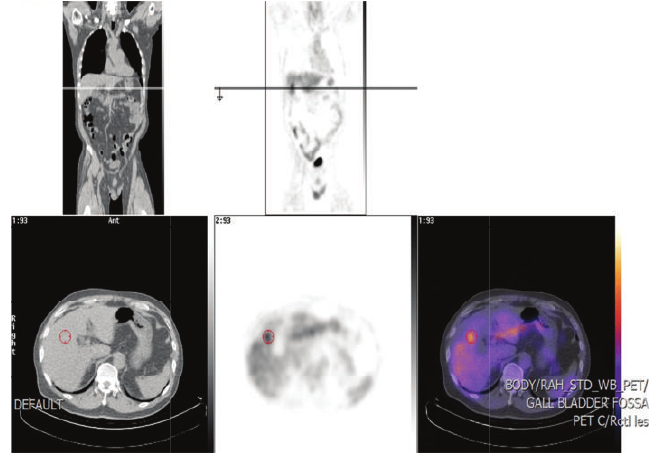
Figure 3: High FDG uptake in gallbladder fossa on PET